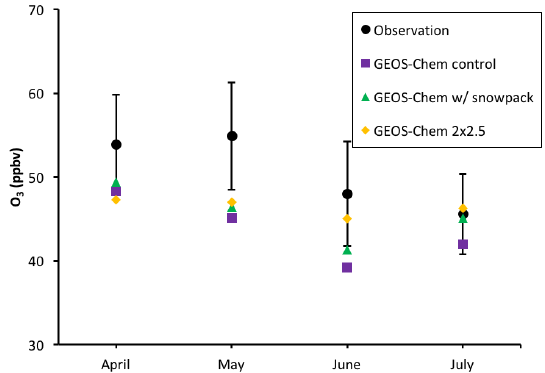
Figure 6. Monthly mean surface O 3 mixing ratios from observa- tions (black circles), GEOS-Chem control runs (purple squares), simulations with snowpack chemistry (green triangles), and sim- ulations with a horizonal grid resolution of 2 ◦ × 2.5 ◦ (orange dia- monds) for April–July. Vertical bars denote the variability over the course of observations for each